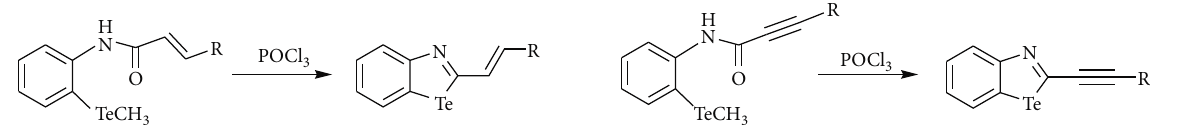
Figure 2: Previously reported cyclizations of benzenetelluroles carrying α , β -unsaturated amide functionalities; R � phenyl.